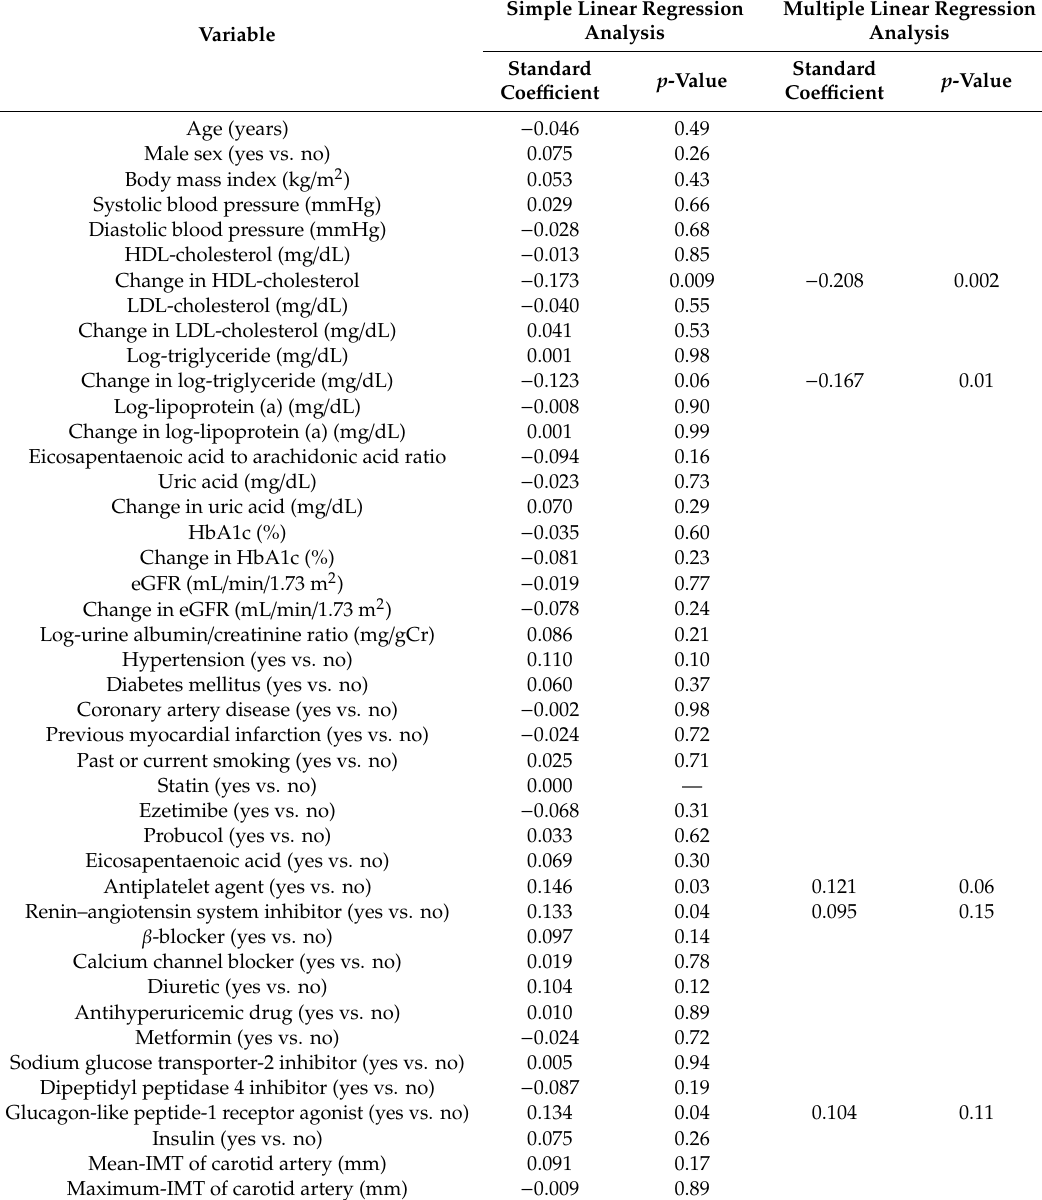
Table 4. Simple and multiple linear regression analyses of variables potentially associated with the change in carotid maximum IMT during the administration of